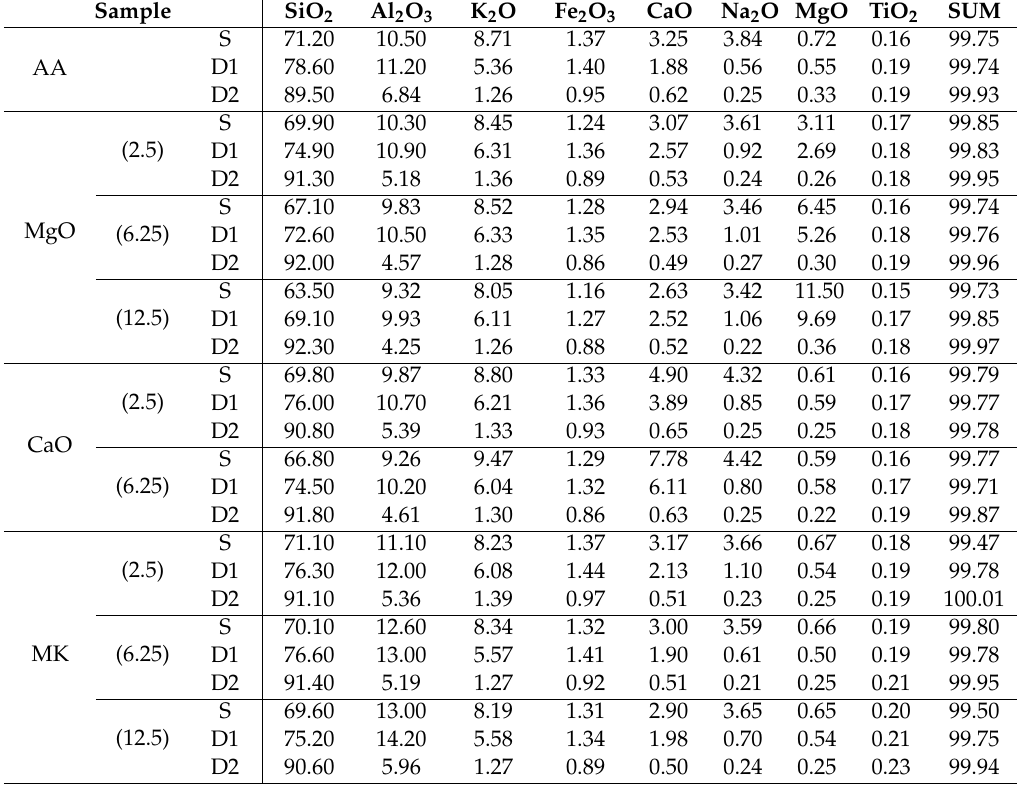
Table A1. Chemical composition of